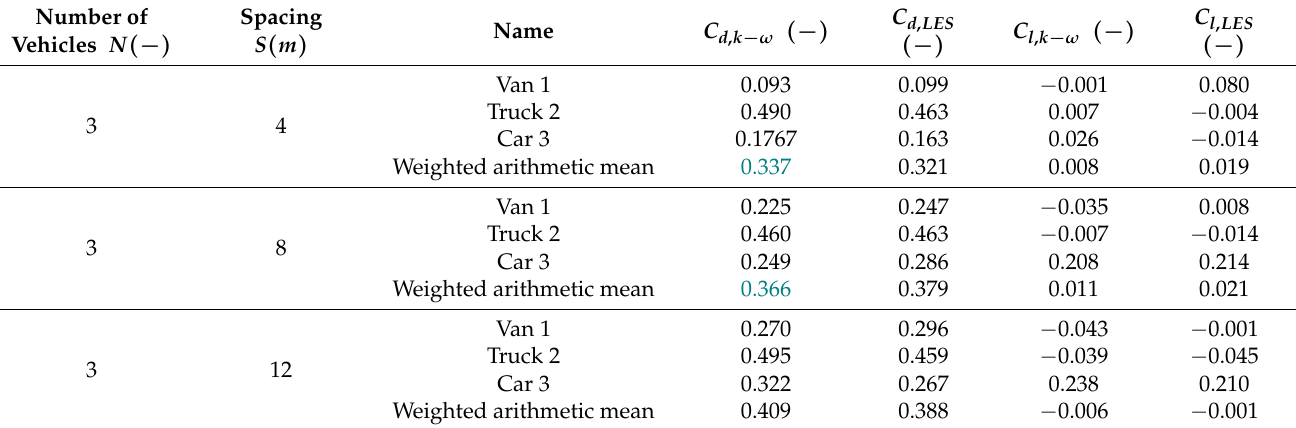
Table 5. Drag coefficient and lift coefficient of vehicles in heterogeneous columns